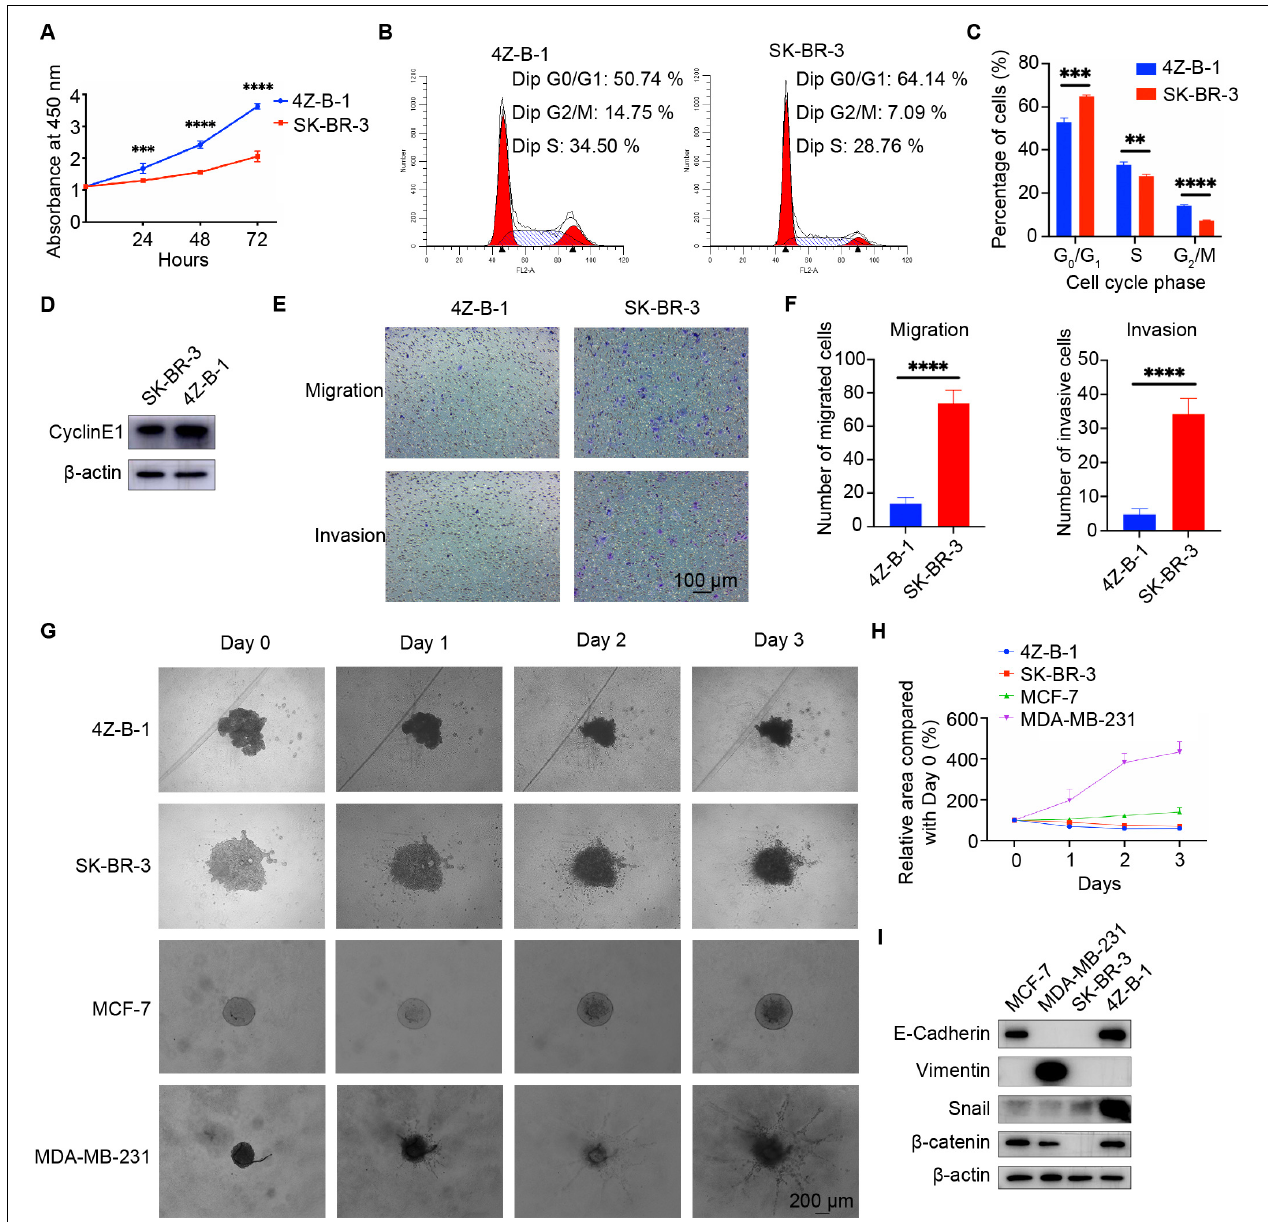
FIGURE 3 | Proliferative, migratory and invasive potential of the 4Z-B-1 cell line. (A) Growth curves of 4Z-B-1 and SK-BR-3 cells determined by the CCK8 assay. (B,C) Distribution of 4Z-B-1 and SK-BR-3 cells determined by flow cytometry and statistical analysis. (D) Expression of CyclinE1 in 4Z-B-1 and SK-BR-3 cells assessed by Western blotting. (E,F) Representative micrographs and statistical analysis of migrated and invasive 4Z-B-1 and SK-BR-3 cells. (G,H) Representative micrographs and statistical analysis of the invasive area of 4Z-B-1, SK-BR-3, MCF-7, and MDA-MB-231 mammospheres in Matrigel. (I) Expression of EMT markers in 4Z-B-1, SK-BR-3, MCF-7, and MDA-MB-231 cells determined by Western blotting. **** p < 0.0001. Magnification, (E) × 100; (G) ×